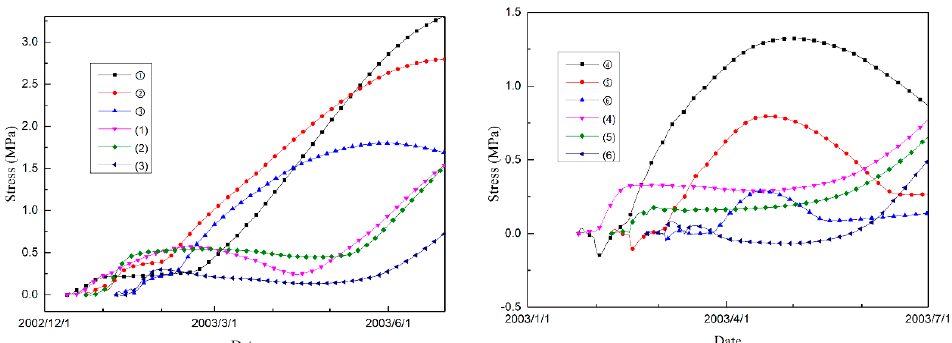
Figure 8. Max principal stress histories of different typical points.